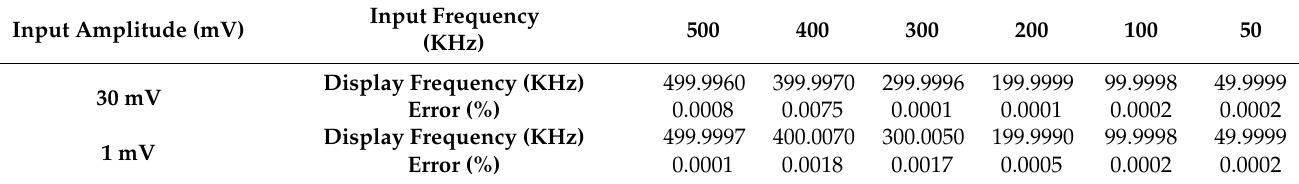
Table 2. Low-frequency sine channel